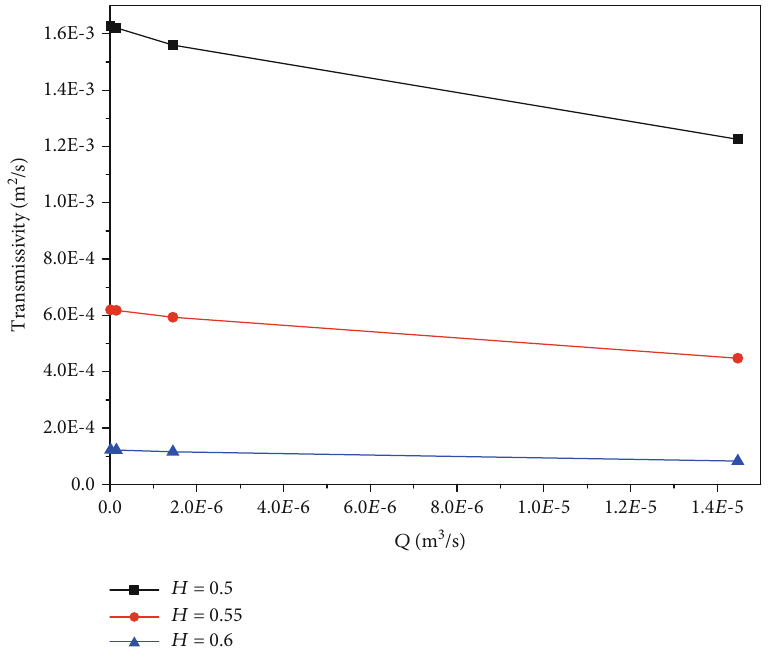
Figure 11: Transmissivity varies with fl ow rate with σ